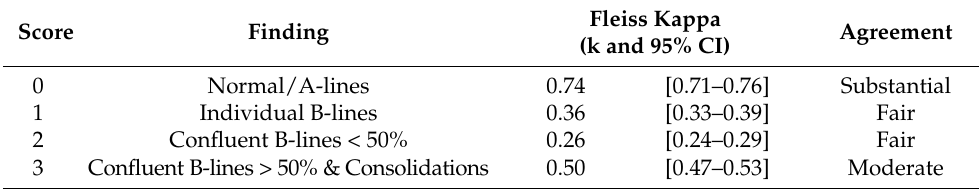
Table 1. Fleiss kappa analysis of the inter-rater agreement in the findings in all the videos.